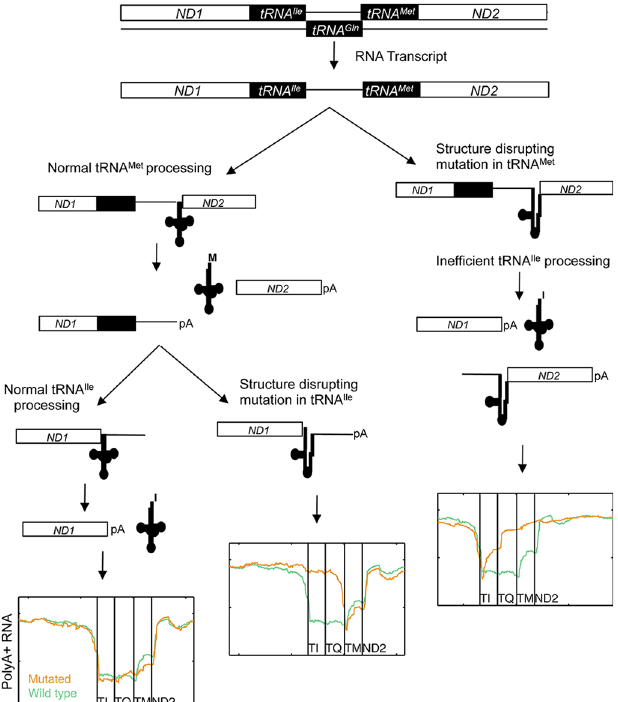
Fig 5. Proposed model of mt-tRNA processing in light of observed RNA species in human cancers. The normal processing cascade is depicted (left-hand side). The data in Fig 4 suggests that proper folding of the pre-tRNAs is important for RNAse P/Z processing. Structure-disrupting mutations in tRNA Ile allow for normal processing of the tRNA Met , but leave polyA+ processing-intermediate products with mutation-bearing tRNA Ile and the antisense- tRNA Gln sequences on the 3 ’ end of ND1 (middle). This implies that the antisense tRNA Gln is not a substrate for tRNA processing endonucleases. Structure-disrupting mutations in the tRNA Met gene lead to the accumulation of intermediates in which the antisense tRNA Gln and mutation-bearing tRNA Met sequences remain attached to the 5 ’ end of the ND2 gene (right-hand side). Processing of the wild type tRNA Ile still occurs but at reduced efficacy, consistent with a model whereby processing of a multi-tRNA cluster occurs preferably in the 3 ’ to 5 ’